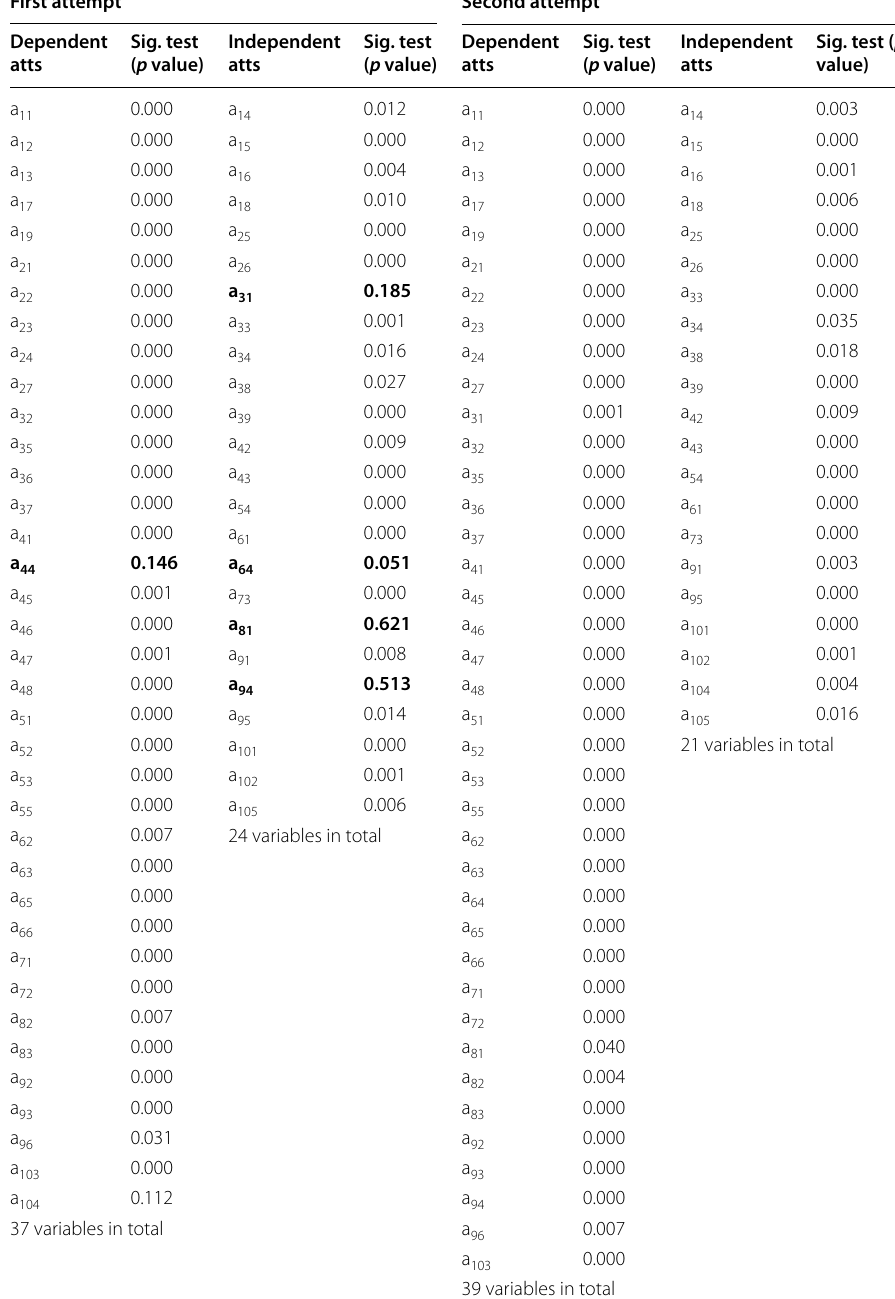
Table 3 MANOVA results for between-subject